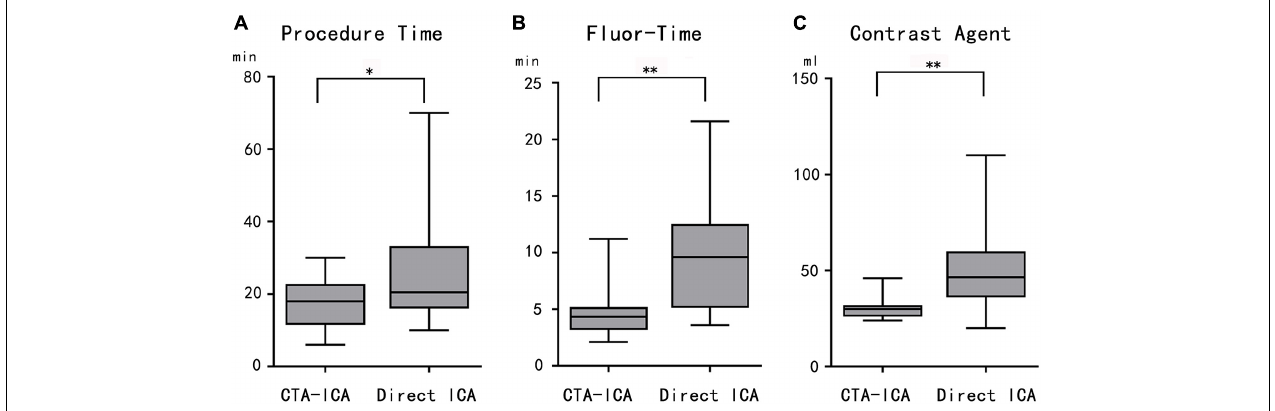
FIGURE 3 | The comparison between CTA–ICA and direct ICA groups. The procedure time (A) , fluor-time (B) , and contrast agent consumption (C) of the CTA–ICA group are significantly decreased comparing with the direct ICA group. CTA, computed tomographic angiography; ICA, invasive coronary angiography; fluor-time, fluoroscopy time; ∗ p < 0.05, ∗∗ p <